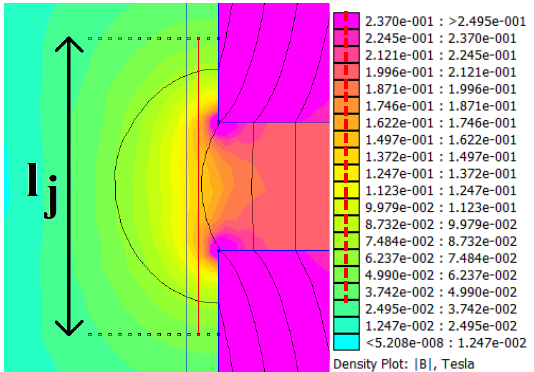
Figure 5. Graphical interpretation of the evaluation of magnetic induction around the space of core air gap.